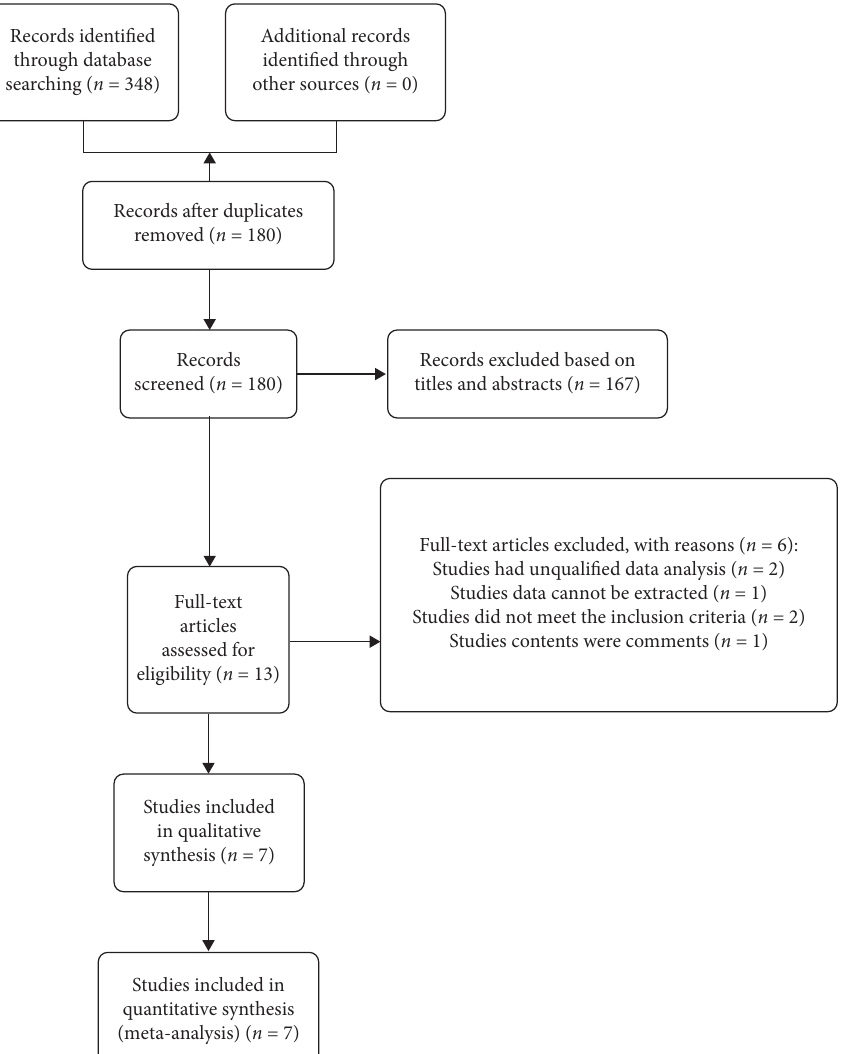
Figure 1: Flow diagram of the article selection process for